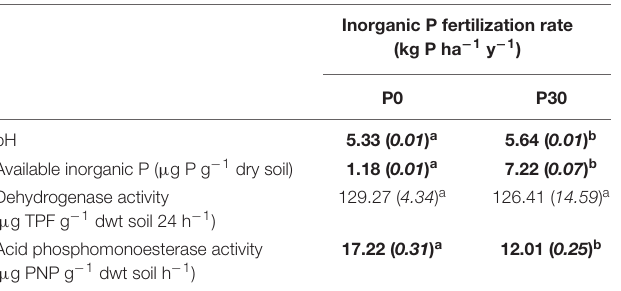
TABLE 1 | Mean baseline soil pH, available inorganic phosphorus (P) concentrations and enzymatic activities measured in unfertilized (P0) ( n = 3) and fertilized (P30) field soil ( n = 3) from a long running (44 years) P fertilization trial (prior to experimental manipulation).